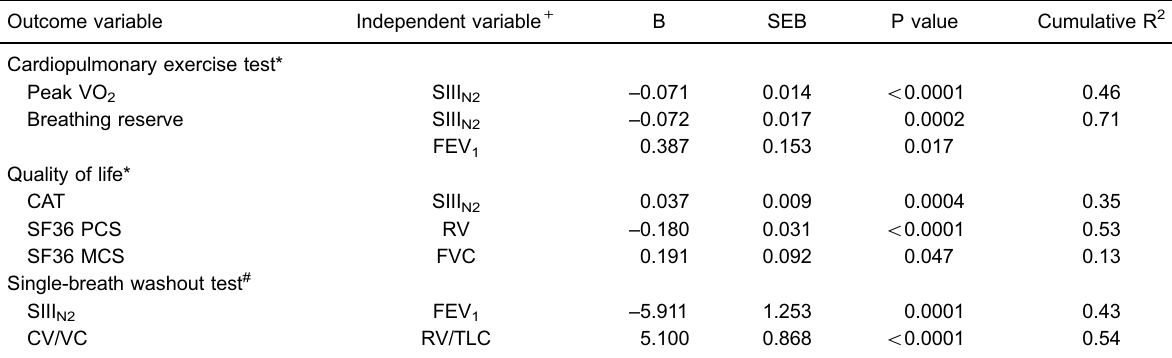
Table 3. Independent linear models for variables of cardiopulmonary exercise test, quality of life and single-breath washout test using resting pulmonary function variables. Outcome